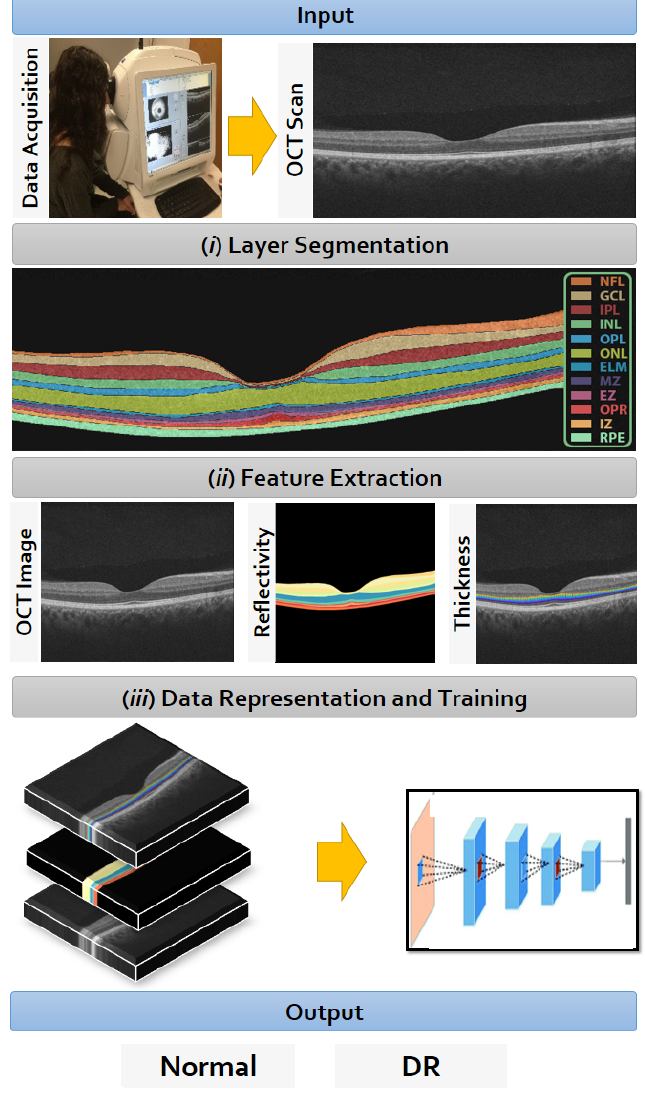
Figure 1. Proposed CAD system for DR diagnostic using